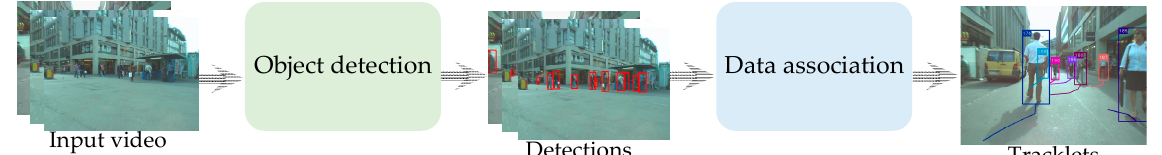
Figure 2. The basic framework of tracking-by-detection.